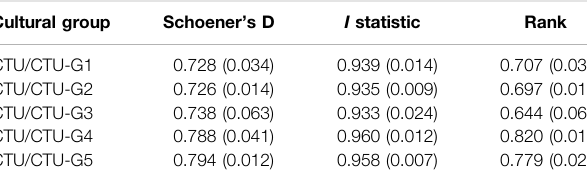
TABLE 9 | Schoener ’ s D, I statistic, and relative rank niche overlap statistics (0 = no overlap; 1 = perfect overlap) between the CTU model and each cultural